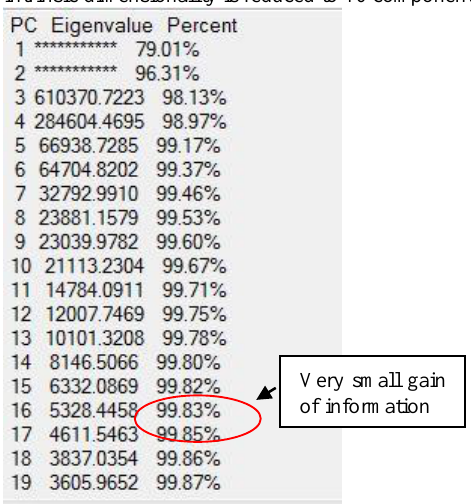
Figure 6. Percentage depiction of gain in variance with